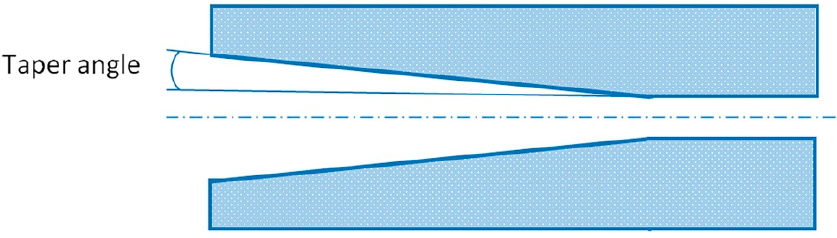
Figure 5. Angle of taper of the heated die.